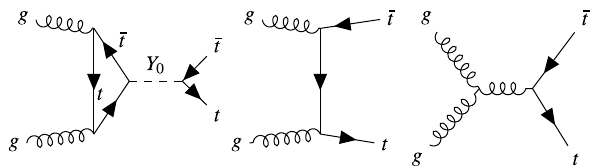
Fig. 1 RepresentativeFeynmandiagramsfora tt productionviaspin-0 mediator ( Y 0 ) and via the